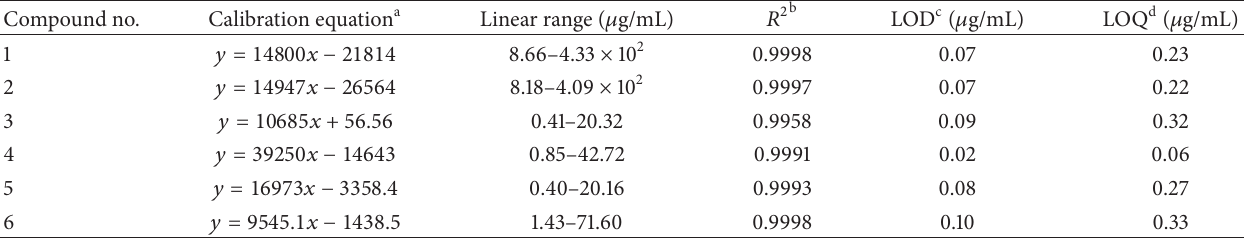
Table 1: Calibration curves, detection limits, and quantification limits of the compounds. Compound no.